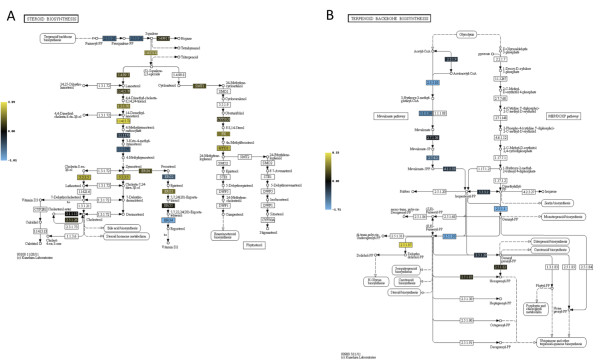
Hypoxia increases transcript levels of enzymes involved in terpenoid and ergosterol biosynthesis. A. KEGG heat map representation of genes involved in steroid (ergosterol) biosynthesis and B. terpenoid (isoprenoid) biosynthesis. The median value from three biological replicates was used. If multiple transcripts exist for a given enzymatic step (i.e. HmgA and HmgB for 2.3.3.10), the transcript with the highest amplitude was used. Microarray data compares mRNA levels of wild type A. fumigatus at the indicated times after exposure to hypoxic conditions to time point immediately prior to hypoxia exposure (0 hours). Yellow indicates transcript levels are increased compared to normoxia (0 hours). Blue indicates transcript levels are reduced compared to normoxia (0 hours).